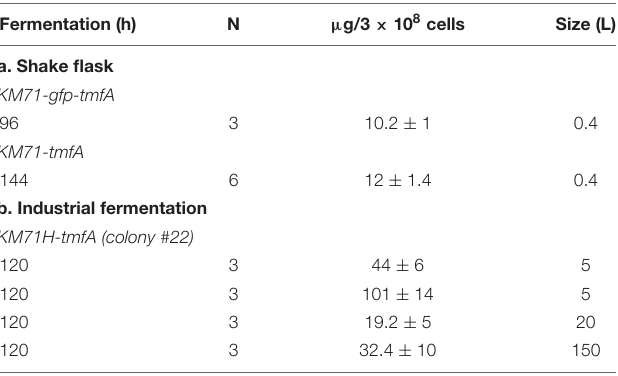
engineered cells expressing TMOF can be used to control